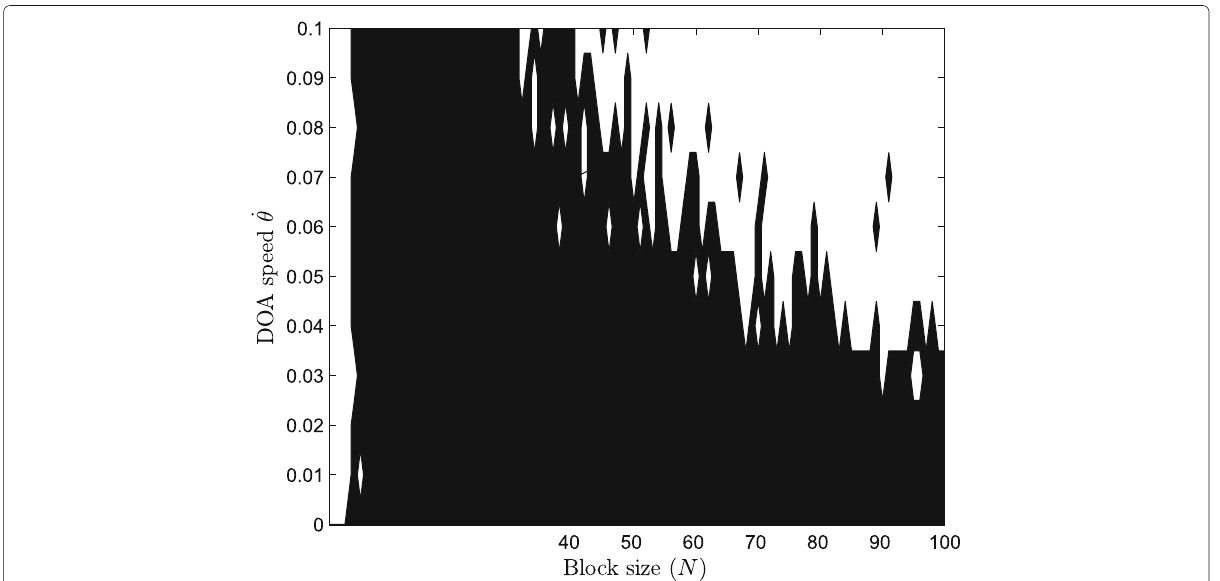
Fig. 7 Operational regions for the AF-based ( whitesurface ) and the root-MUSIC ( blacksurface ) estimators with K = 2, N a = 8, and SNR = 25 dB